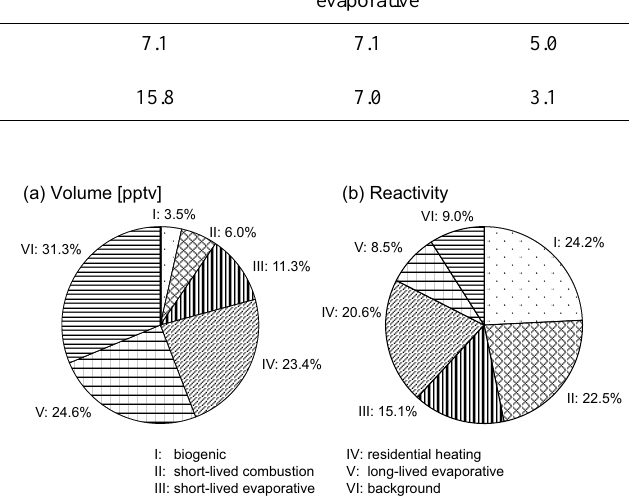
Figure 6. Contributions of individual factors to the total amount of modeled NMHCs (pptv) (left) and to the total OH reactivity of modeled NMHCs (s − 1 )